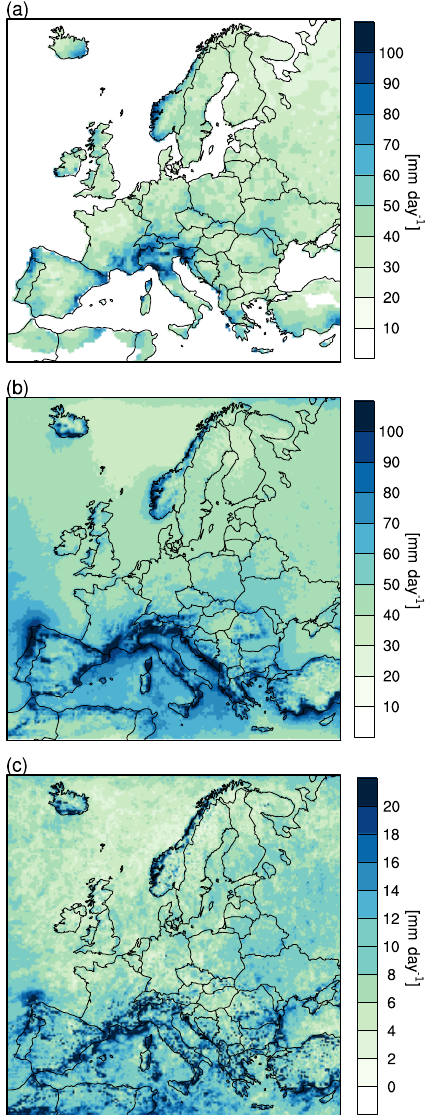
Figure 4. 10-year return level of daily precipitation in the E-OBS data set and the EURO-CORDEX simulations for the period 1971– 2000. (a) E-OBS data set (b) ensemble mean of EURO CORDEX simulations (c) ensemble SD.